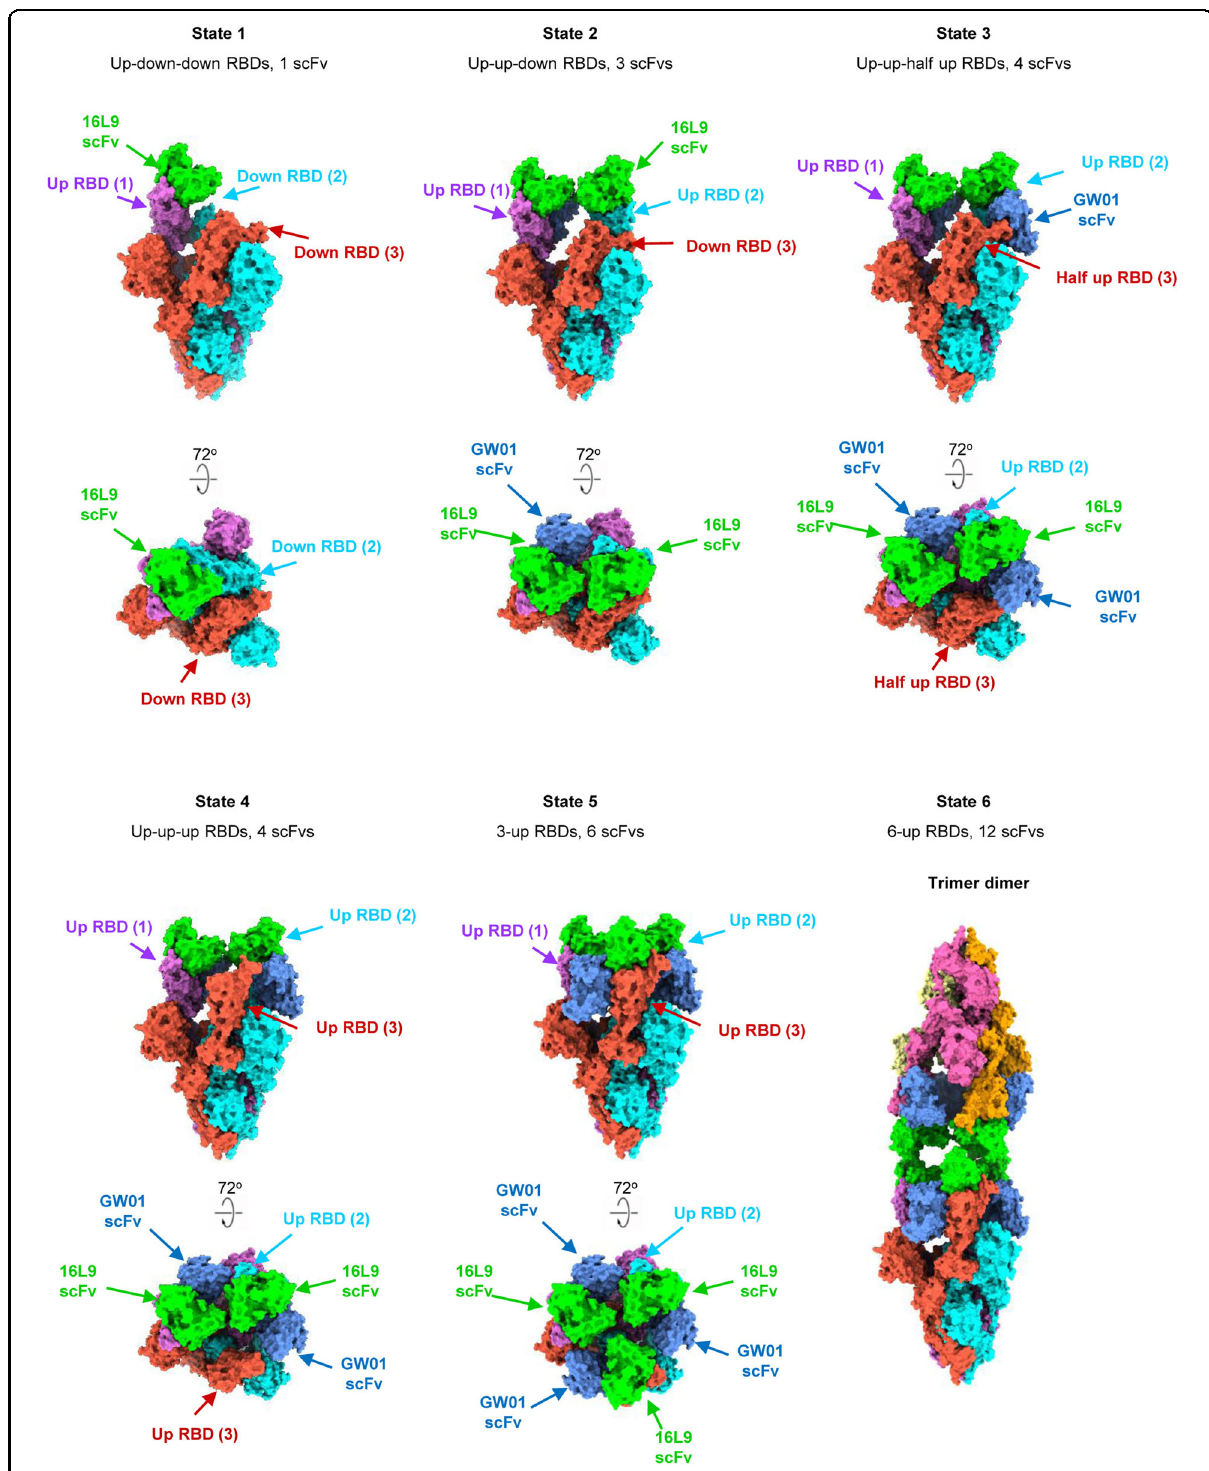
Fig. 3 Cryo-EM structures of the Omicron S trimer in complex with the bispeci fi c antibody FD01 IgG. Cryo-EM structure of the prefusion stabilized SARS-CoV-2 Omicron S ectodomain trimer in complex with the bispeci fi c antibody GW01-16L9 (FD01) IgG, revealing 6 states of the complex. State 1: up-down-down RBDs, 1 scFv, 3.47 Å. State 2: up-up-down RBDs, 3 scFvs, 3.70 Å. State 3: up-up-half-up RBDs, 4 scFvs, 3.91 Å. State 4: up-up-up RBDs, 4 scFvs, 3.47 Å. State 5: 3-up RBDs, 6 scFvs, 3.87 Å. State 6: trimer dimer, 6-up RBDs, 12 scFvs, 6.11 Å. Two perpendicular views